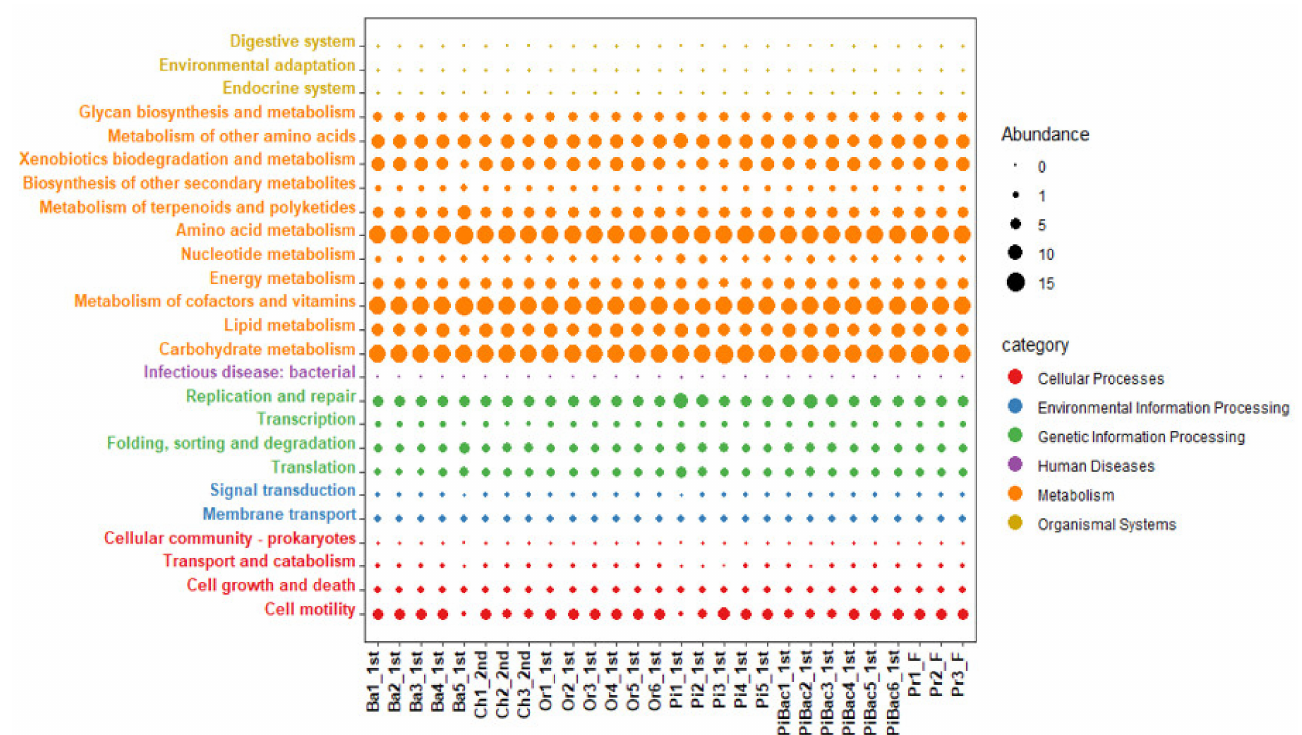
Figure 4. Bubble plot of predicted functions across the fermented fruit samples showing Kyoto Encyclopedia of Genes and Genomes (KEGG) pathway level 2 in different colors on the Y -axis belongs to the first category KEGG pathways (legend at right below). The sample names are shown on the X -axis. The size and color of the bubble indicate the relative abundance of pathways present in each